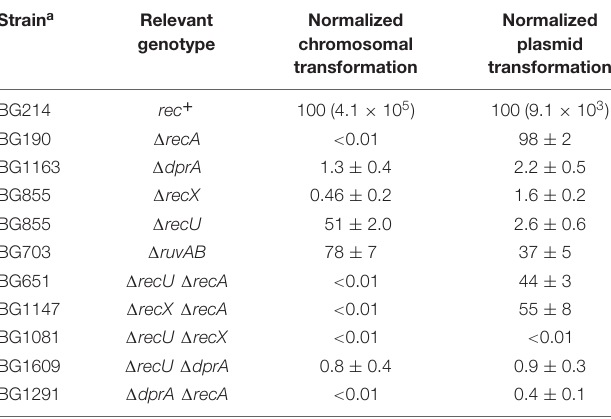
TABLE 1 | The role of RecU in plasmid transformation is superseded in the recA context. Strain a Relevant